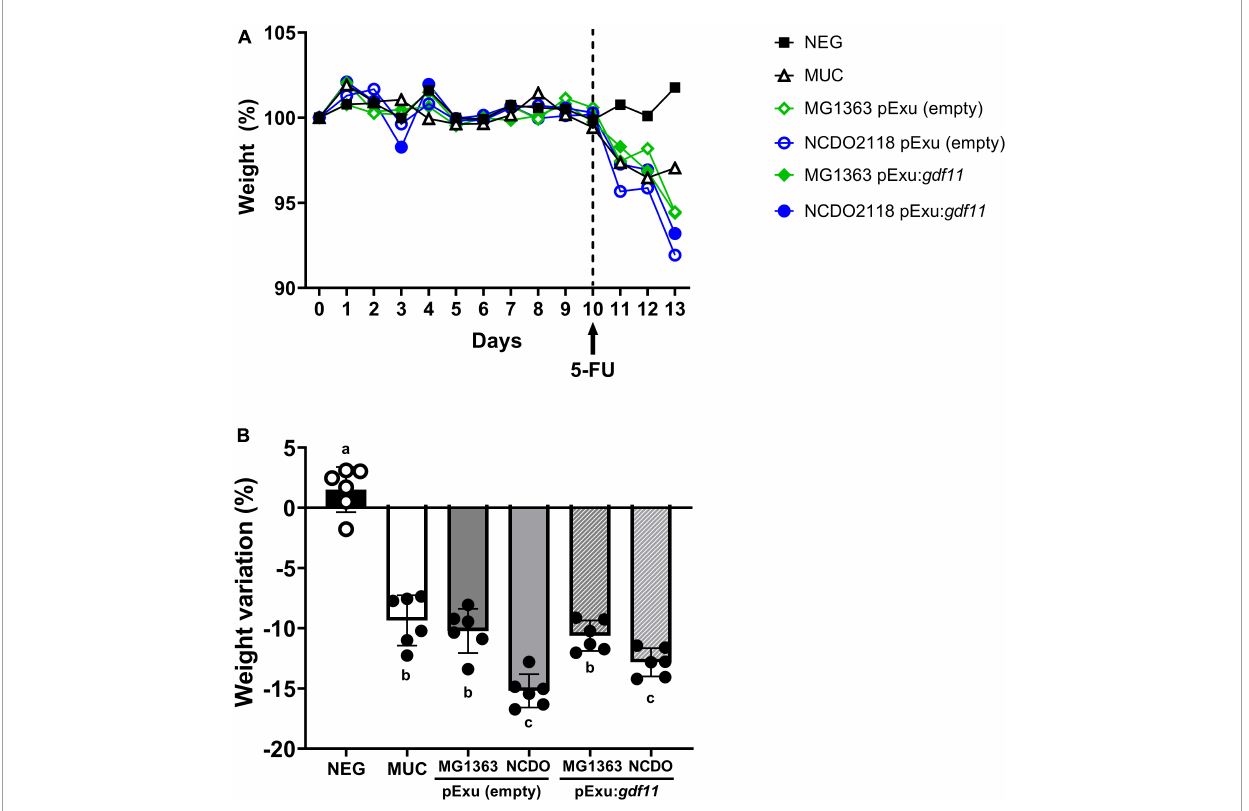
FIGURE1 Evaluation of beneficial effect of recombinant L. lactis (pExu: gdf11 ) on body weight of mice ( n = 6) inflamed with 5-FU. (A) Daily average body weight of mice treated during 13 experimental days. (B) Detailed average body weight loss observed after mucositis induction with 5-FU shows a significant decrease compared to the negative group. Different letters (a, b, and c) represent the significant difference ( p < 0.05) among groups by one-way ANOVA and Tukey’s